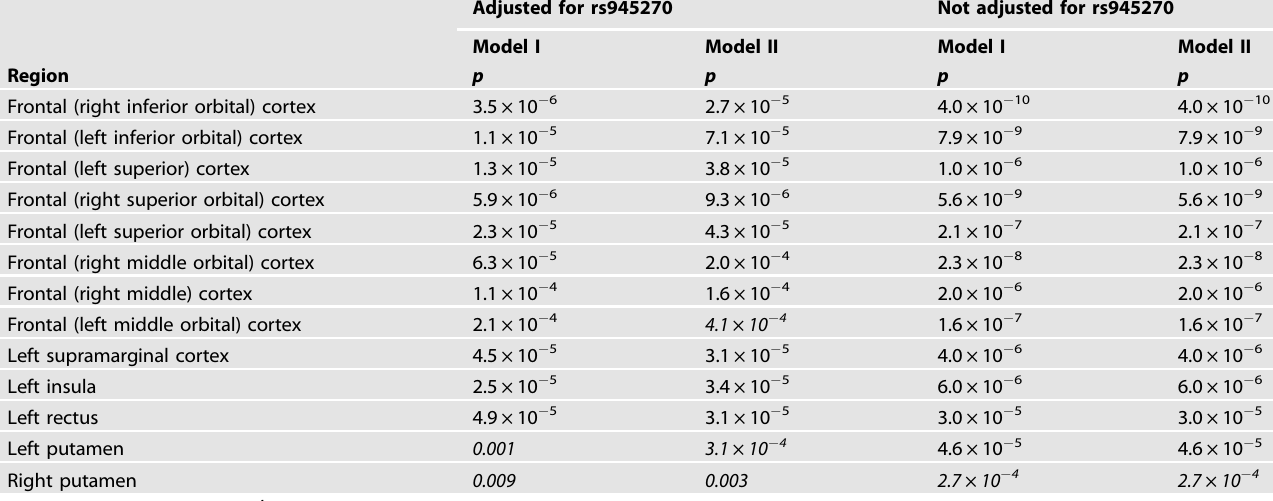
Table 2. Signi fi cant associations between GMVs and ADHD in males.